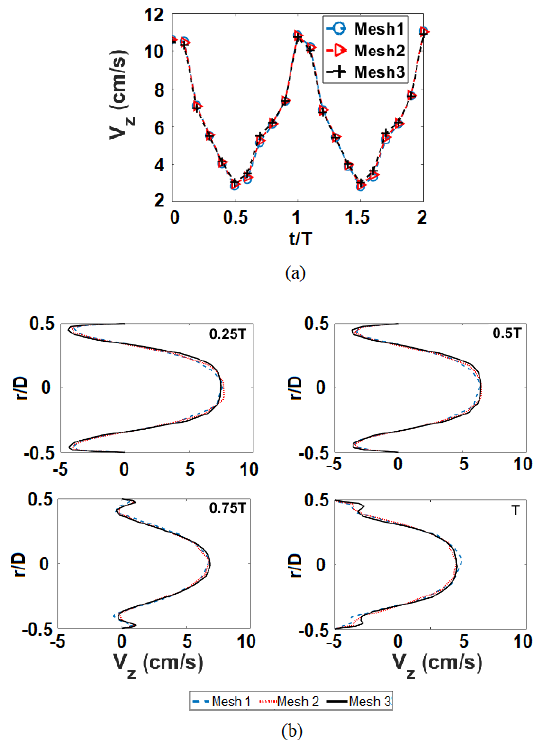
Figure 5: Behavior comparison for three meshes: 180958 elements (Mesh 1), 351569 elements (Mesh 2) and 951899 elements (Mesh 3). (a) Axial velocity at r = 0, z = 0 vs time and (b) Velocity profiles in down- stream location z = 0 . 5 D at 0.25 T , 0.5 T , 0.75 T and T